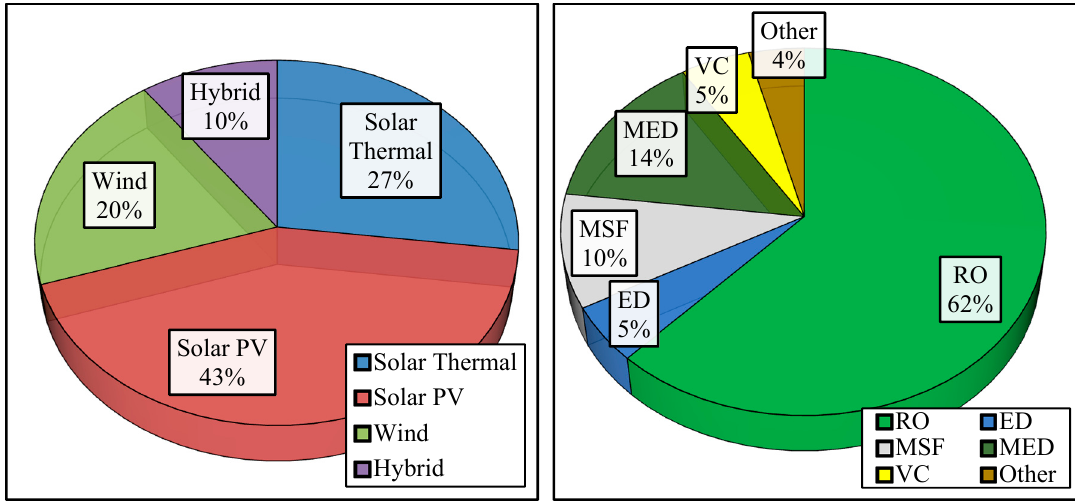
Figure 2. Renewable energy-driven desalination processes and energy sources [11], adapted from Mathioulakis [11], with permission license number 4000740311771 from Desalination (Elsevier), 2007.